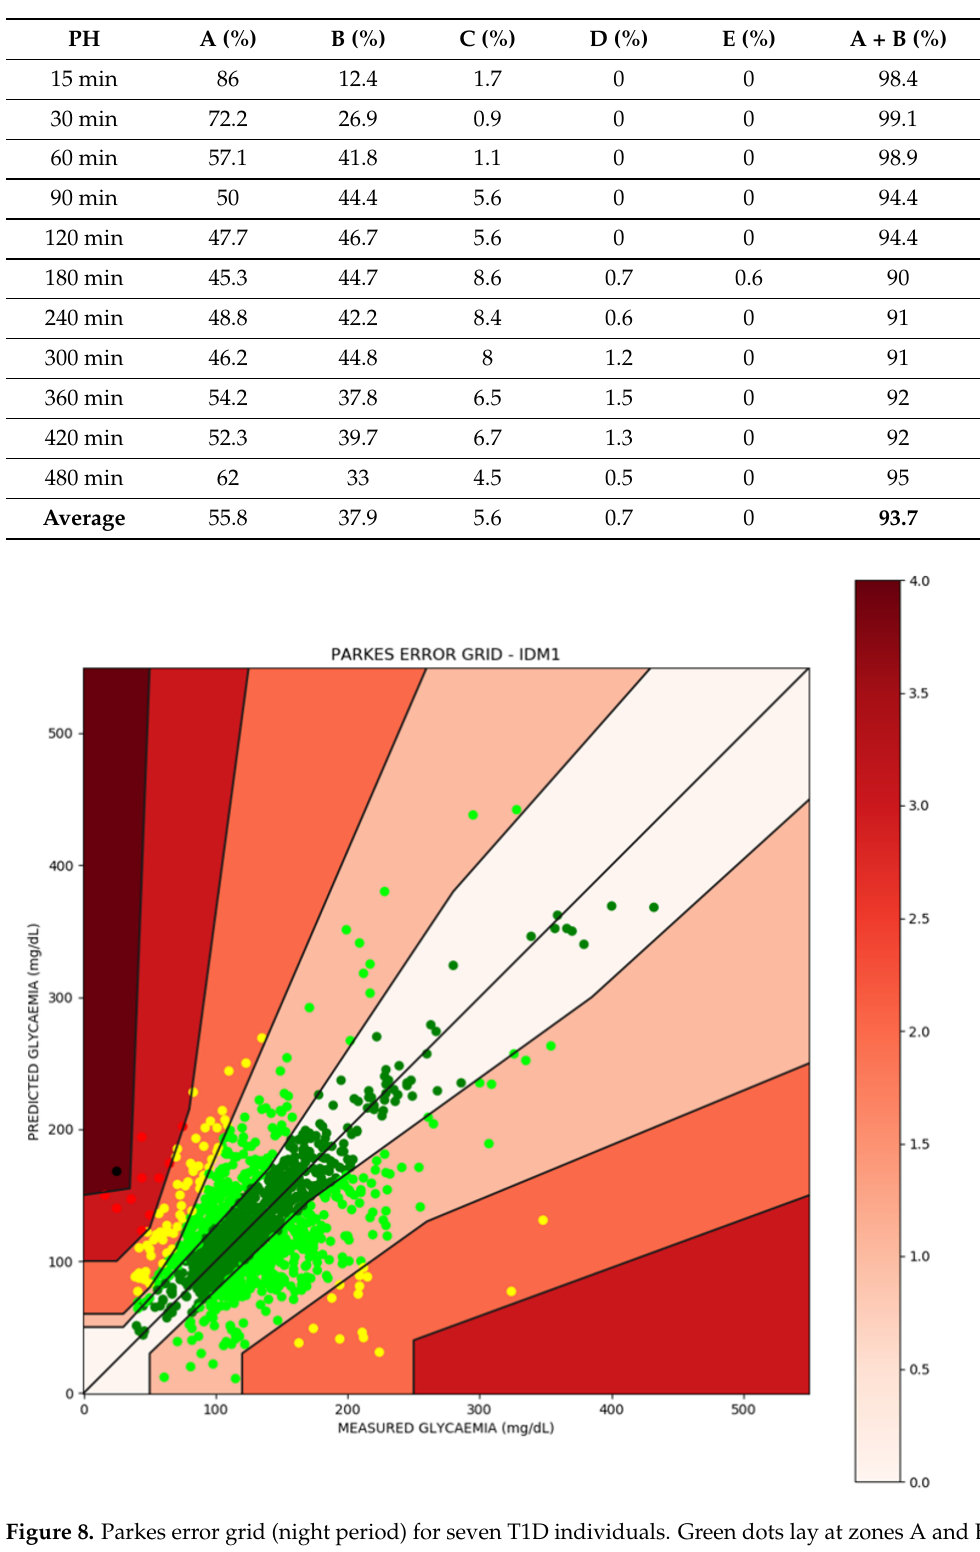
Table 8. Results of PEG for Tesseratus (1400 predictions plotted)—night period.